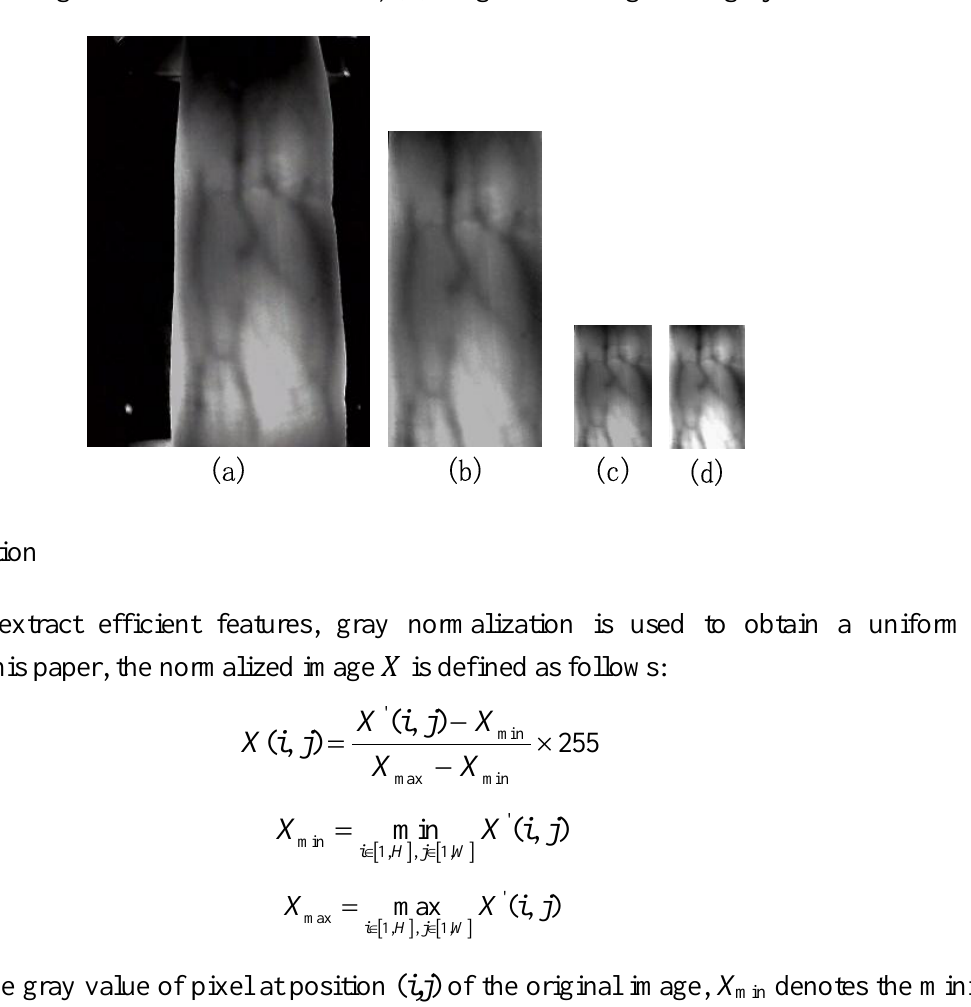
Figure 5. Examples of preprocessing. ( a ) Original finger vein image; ( b ) ROI of (a); ( c ) Finger vein image after size normalization; ( d ) Finger vein image after gray